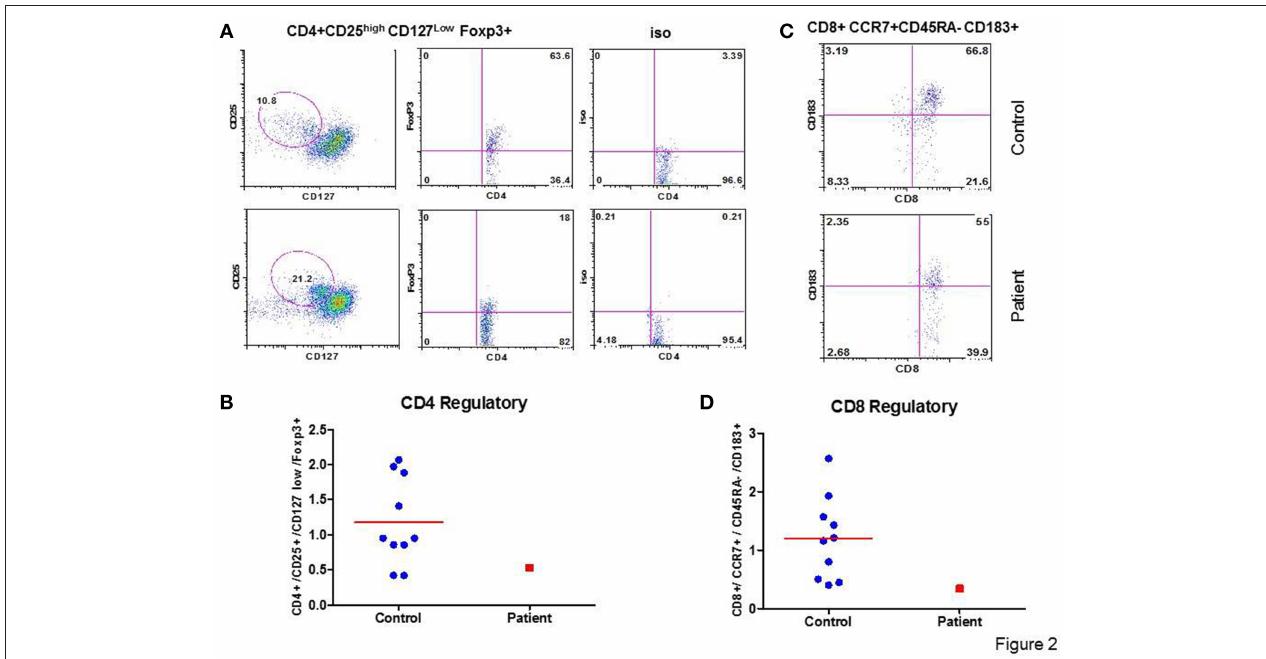
FIGURE 2 | CD4 Treg and CD8 Treg. Flow cytograph for CD4 Treg (A) and CD8Treg (C) in the patient and a simultaneously-analyzed healthy control. Individual data from 10 healthy controls and the patient for CD4 Treg (B) and CD8 Treg (D) are shown. CD4 + Treg and CD8 + Treg are decreased in the patient.